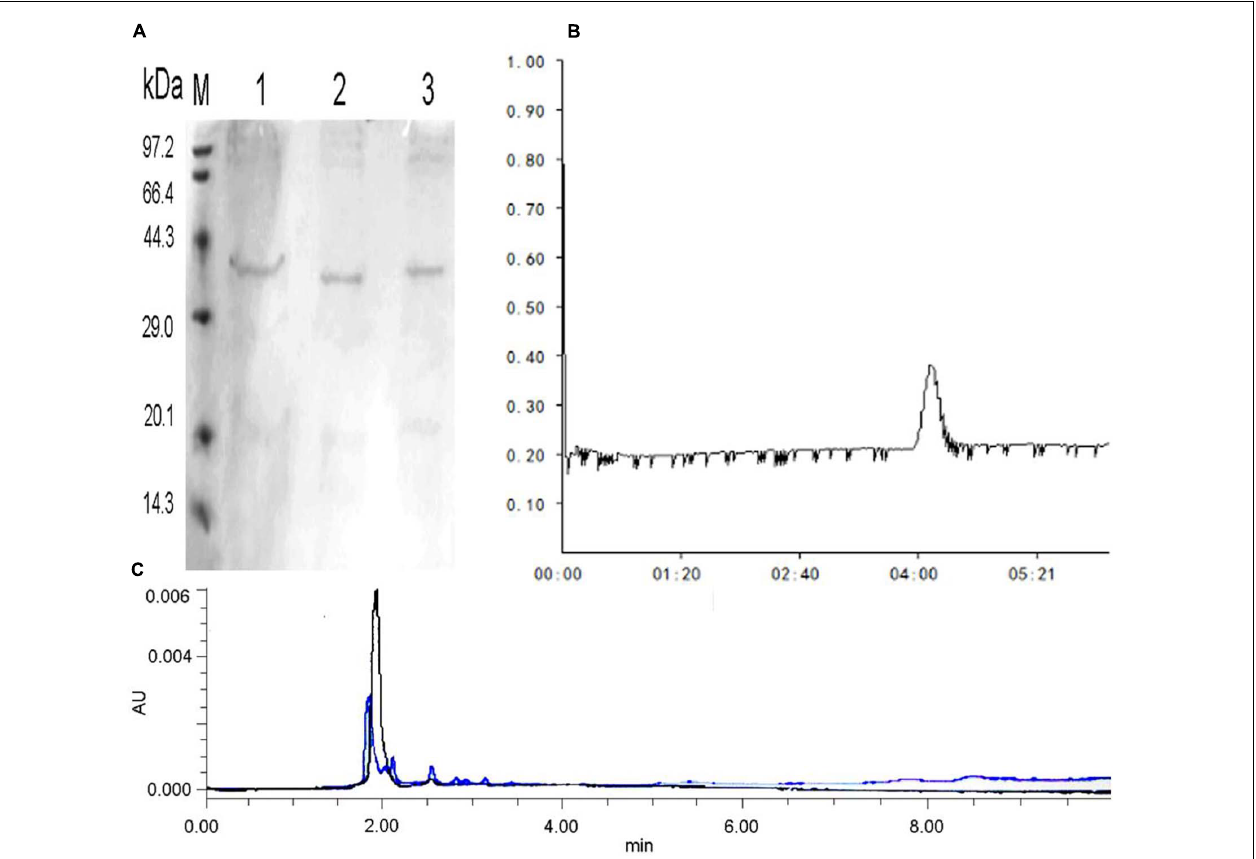
FIGURE 4 | (A) SDS-PAGE electrophoresis of COSE protein obtained by Sephadex G-75 chromatography. Lane M: standard molecular weight (kDa); Lane 1: 20 mg/ml protein; Lanes 2–3: 10 mg/ml protein. (B) Sephadex G-75 of COSE. (C) Analysis of COS hydrolyzates by HPLC. Blue peaks indicate mixed standard of COS degradation products. Black peaks represent COS degradation products by purified COSE from C4